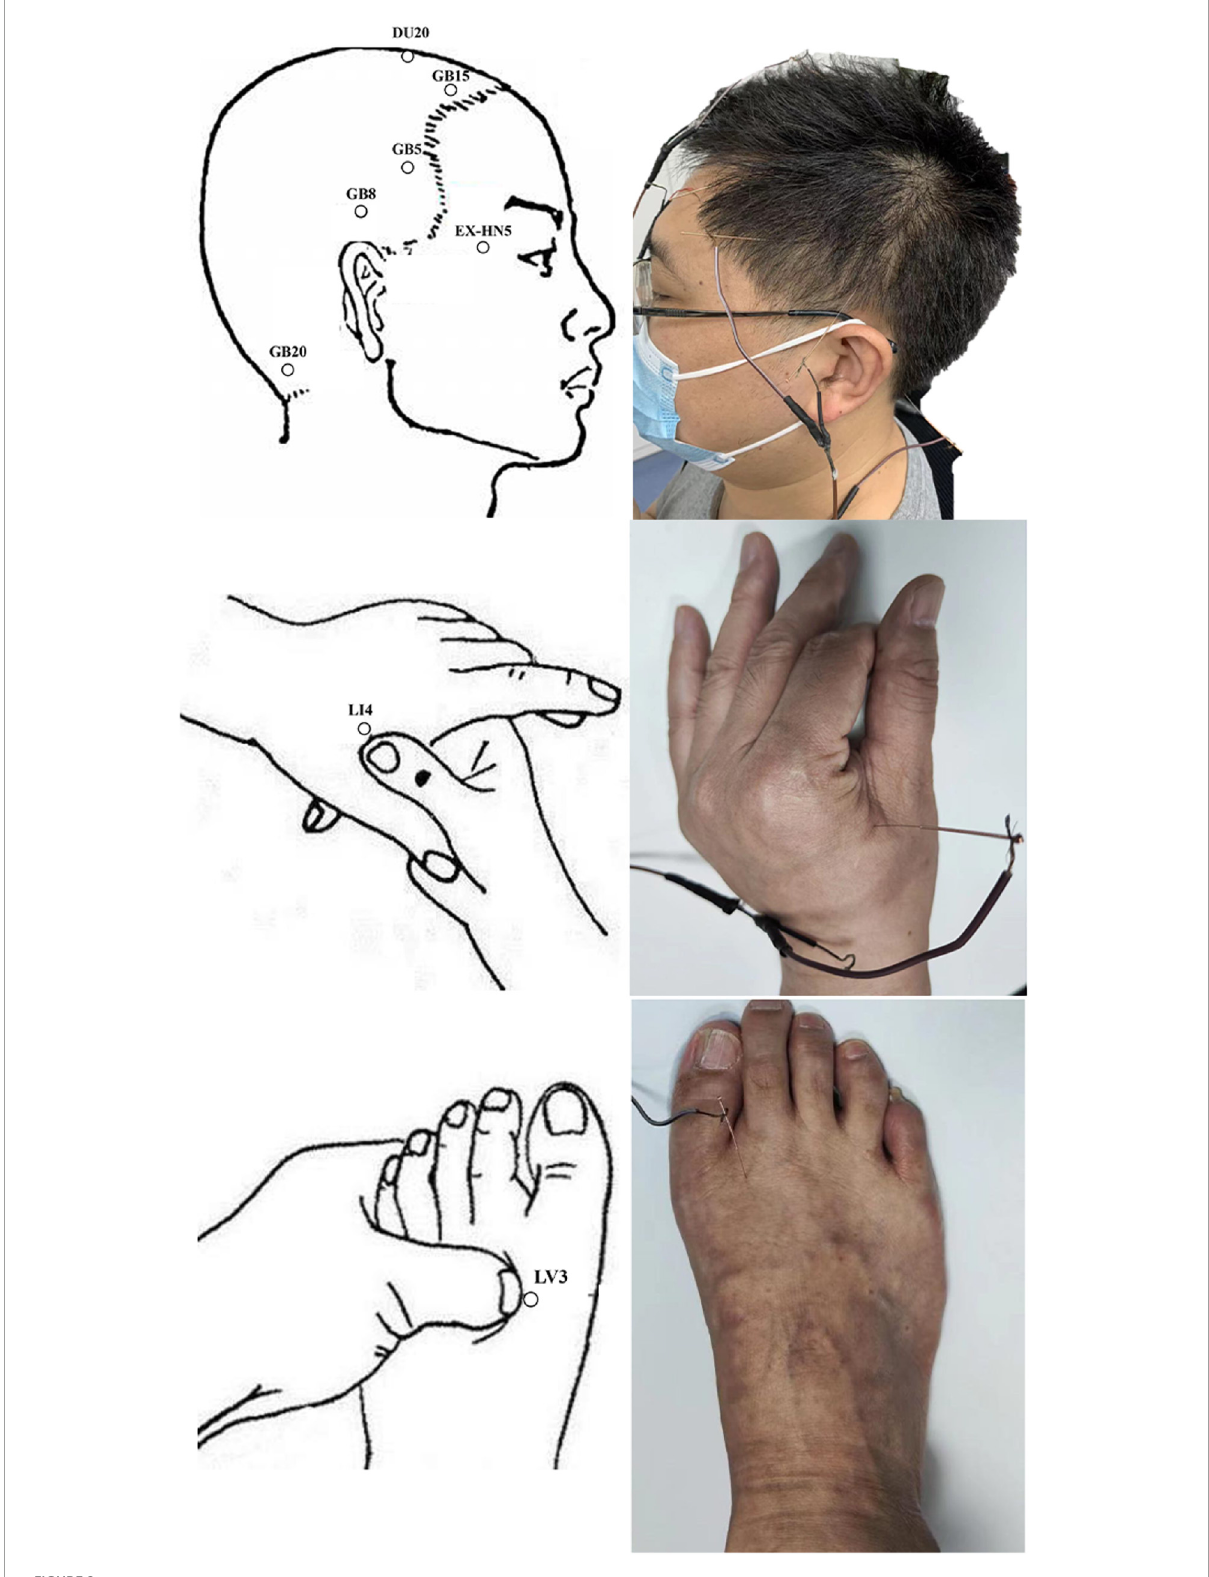
FIGURE2 Diagram of electro-acupuncture